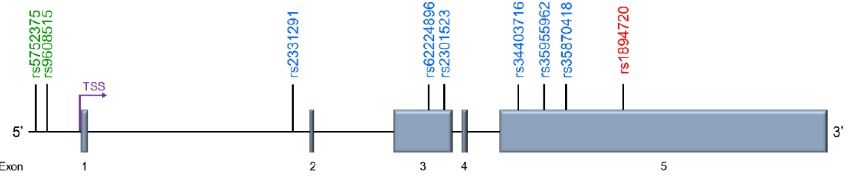
Figure 2. Schematic representation of SNPs in the GOMAFU locus that are associated with acute myocardial infarction (Green), myocardial infarction (Blue), and schizophrenia (Red). The transcription start site (TSS) is indicated by an arrow.